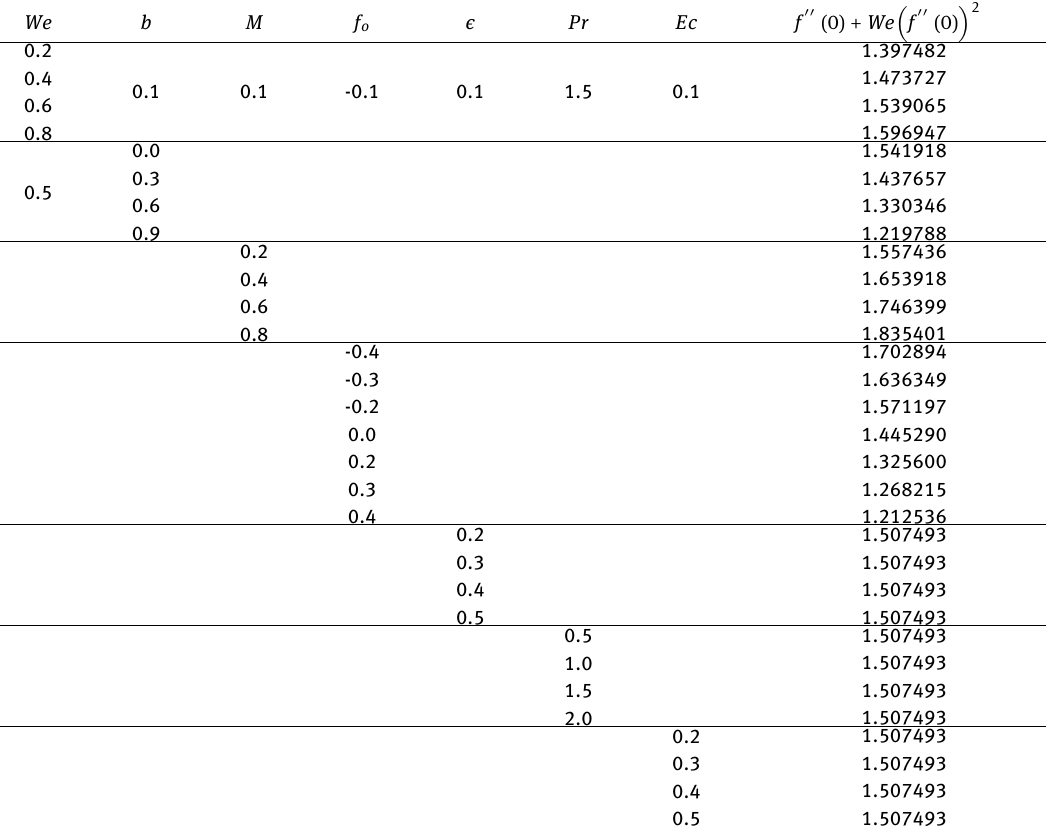
(cid:16) (cid:17) 2 f (cid:48)(cid:48) (0)